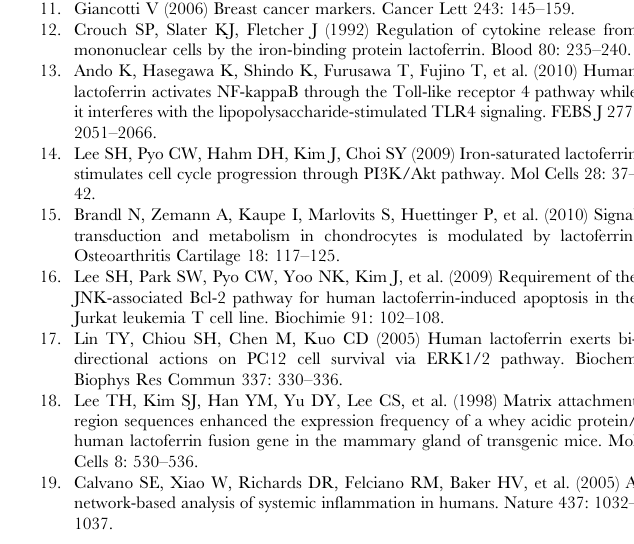
Table S1 Sequences of primers employed in this study. Table S2 Genes in top network displaying differential expression in the sLF expressing cells. Table S3 Genes in top network displaying differential expression in the D LF expressing